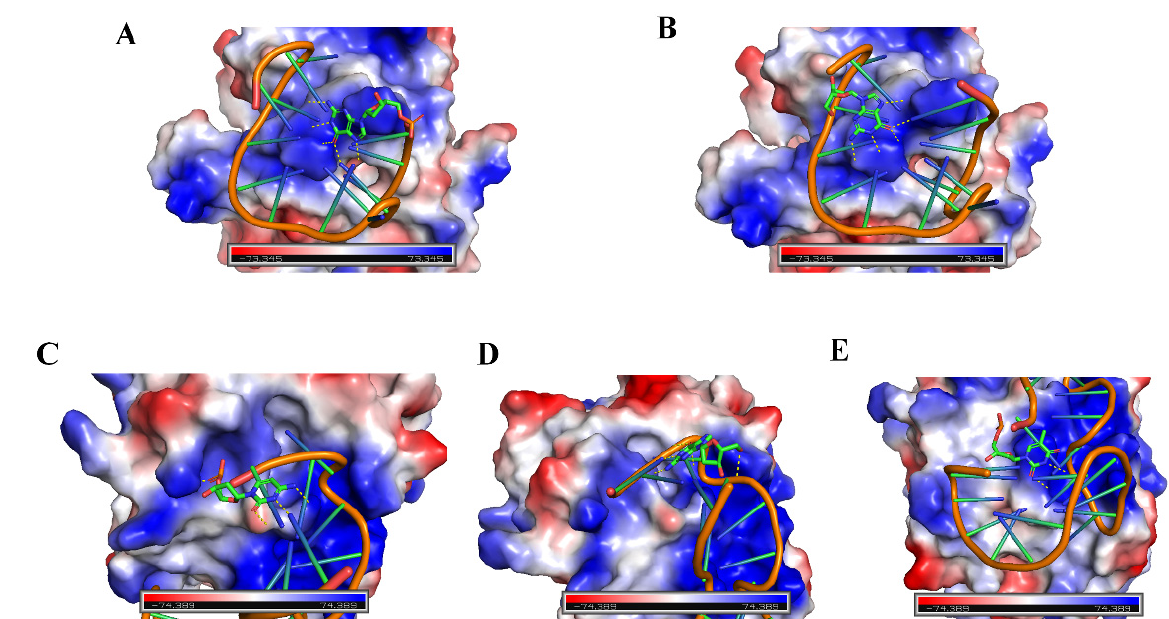
Figure 13. Preliminary insight into structural features on the interface of the aptamer–thrombin complexes. ( A ) Thrombin–Thrombin15 3 ′ site view. ( B ) Thrombin–Thrombin15 5 ′ site view. ( C ) Thrombin–Thrombin27 3 ′ site view. ( D ) Thrombin–Thrombin27 5 ′ site view. ( E ) Thrombin–Thrombin27 T6 site view. Images of structural features (PDB ID: 4I7Y and 4DII) were visualized using PyMOL software.